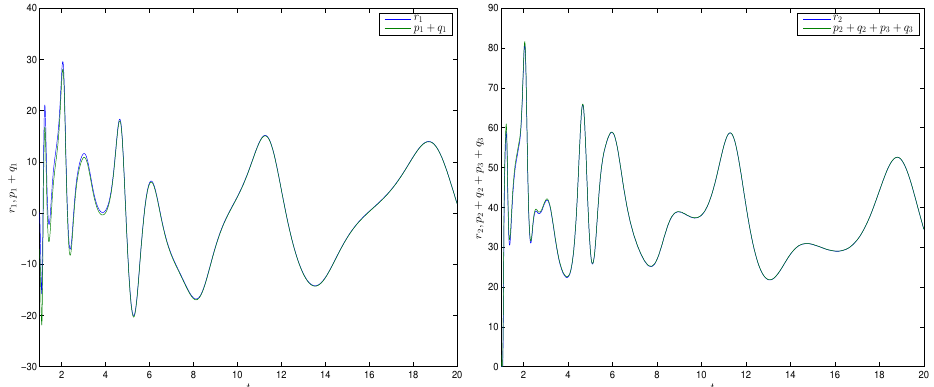
Figure 3. Time trajectories of states r 1 ( t ) , p 1 ( t ) + q 1 ( t ) and r 2 ( t ) , p 2 ( t ) + q 2 ( t ) + p 3 ( t ) + q 3 ( t ) , for Example